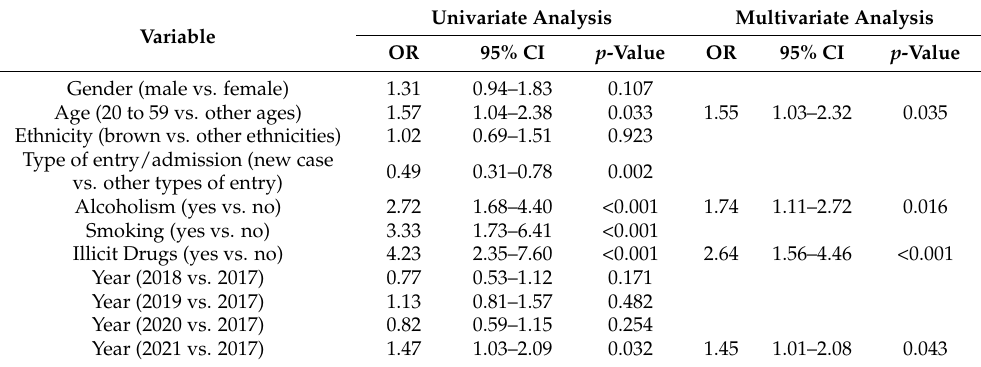
Table 5. Results of the logistic analysis of risk factors for abandoning Tuberculosis treatment in Ananindeua from 2017 to 2021 ( n = 1345). Univariate Analysis Multivariate Analysis Variable OR p